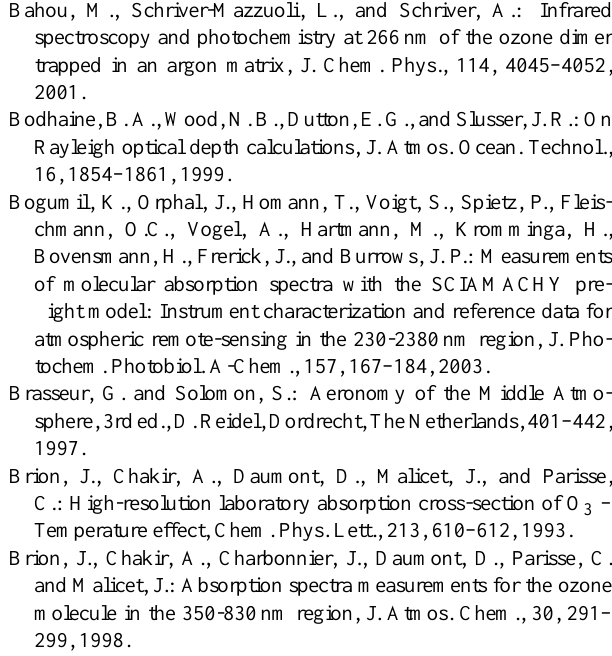
concentrations whose slope is the 617 3